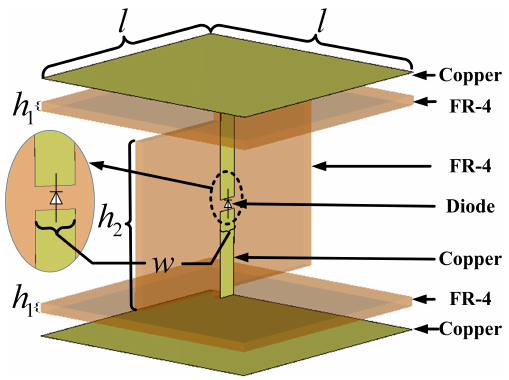
Figure 1. Geometry of the proposed